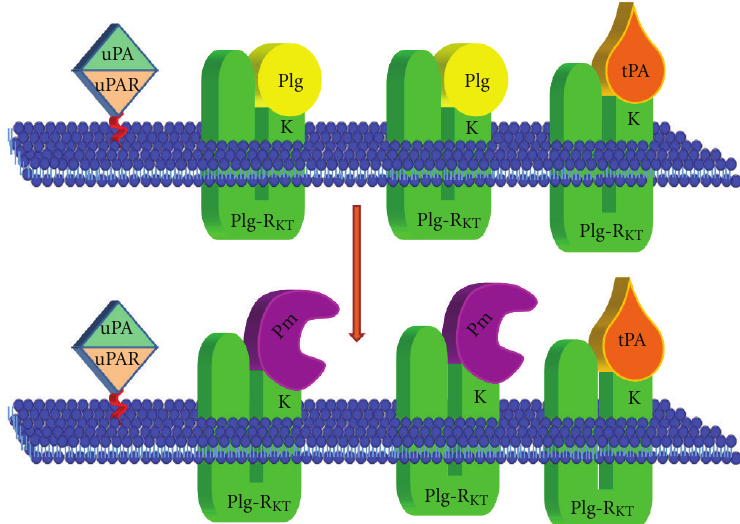
Figure 8: Model for Plg-R KT -dependent cell surface plasminogen activation. Plg-R KT is located on the monocyte surface in close physical proximity to the uPAR. The uPAR brings uPA in close proximity to plasminogen bound to Plg-R KT , thus promoting activation of the bound plasminogen to plasmin. In addition, t-PA also interacts specifically with Plg-R KT , thus mimicking the interaction of t-PA with cellular binding sites. Despite sharing a binding site on Plg-R KT , the relative concentrations of tPA and plasminogen in the circulation should permit simultaneous binding of both ligands to the cell surface, and each tPA molecule should be bound proximally to several plasminogen molecules, thus promoting plasminogen activation to plasmin on the cell